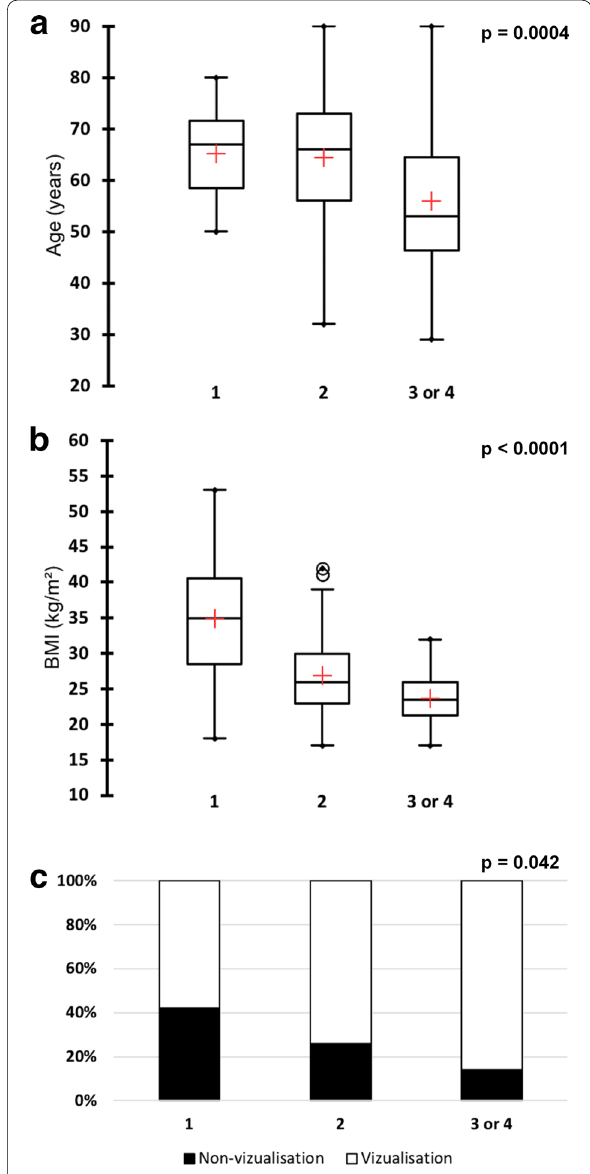
Fig. 1 Comparison of age ( a ) and BMI ( b ) of breast density categories using Kruskal-Wallis tests and comparison of the proportions of sentinel lymph node non-visualization cases among breast density categories ( c ) using a Fischer exact test. BMI: Body Mass Index. Category 1: almost entirely fatty. Category 2: scattered densities. Category 3 or 4: heterogeneous or extremely